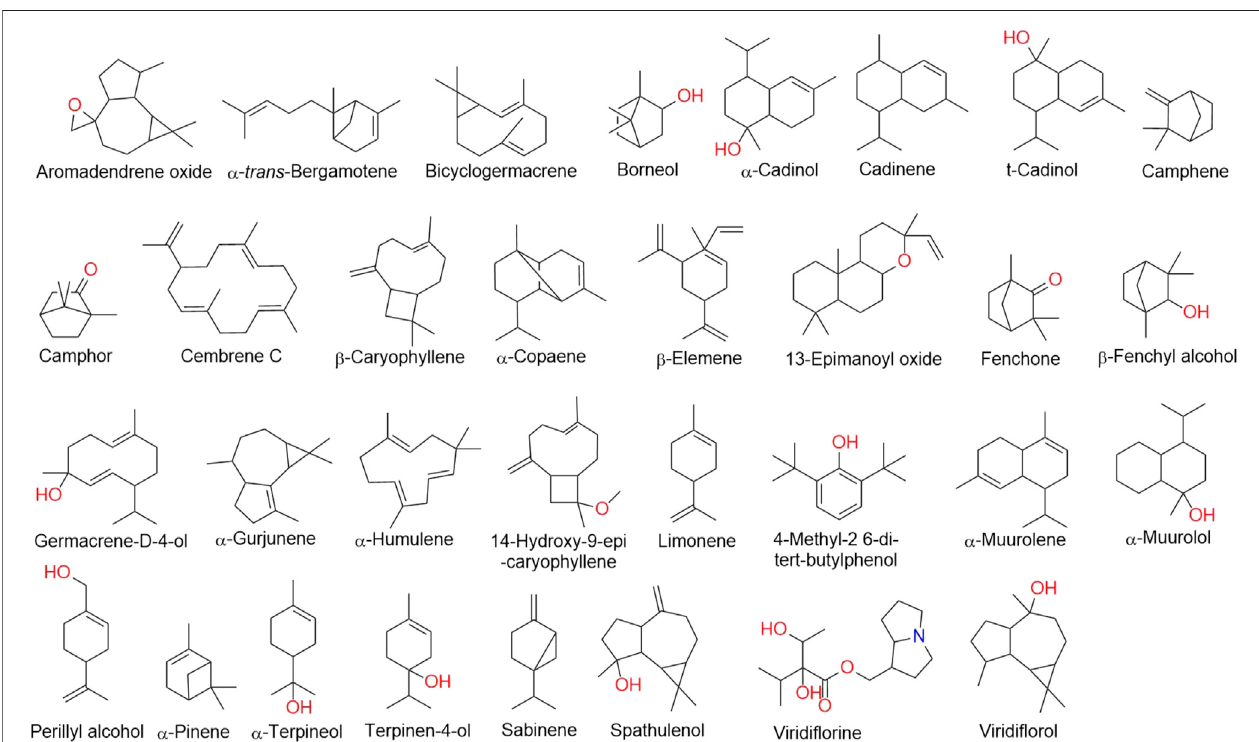
FIGURE 5 | Chemical structures of volatile constituents isolated from T. riparia